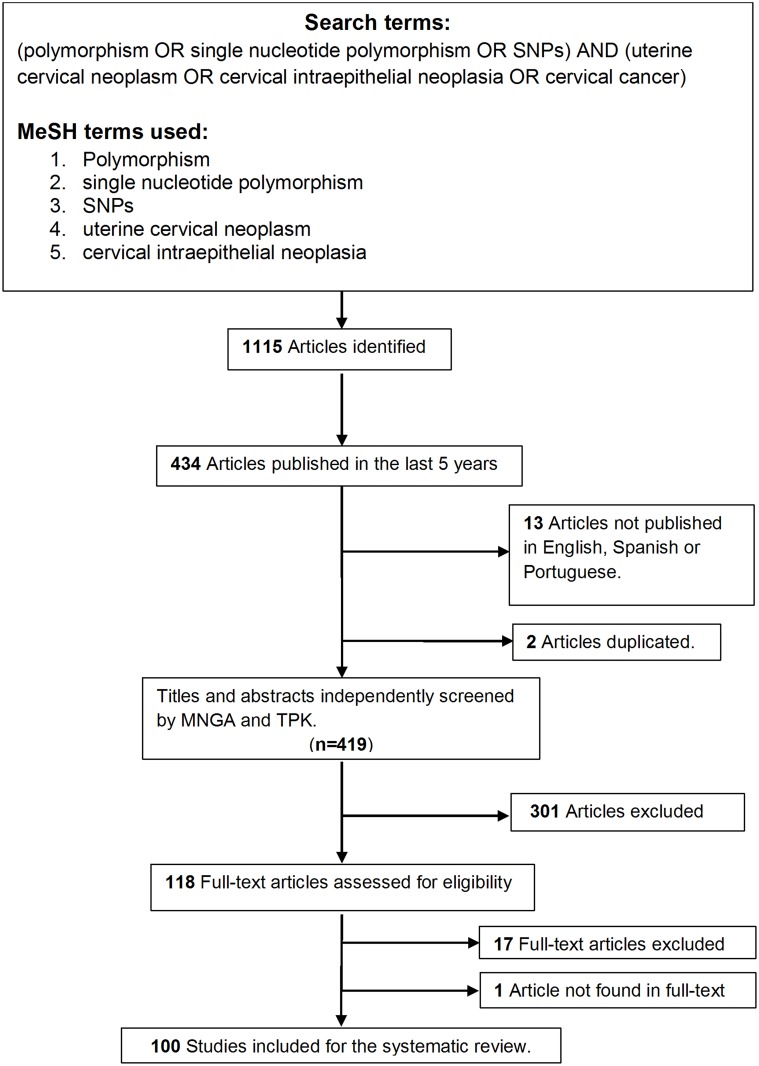
Study selection for inclusion in meta-analysis flowchart.